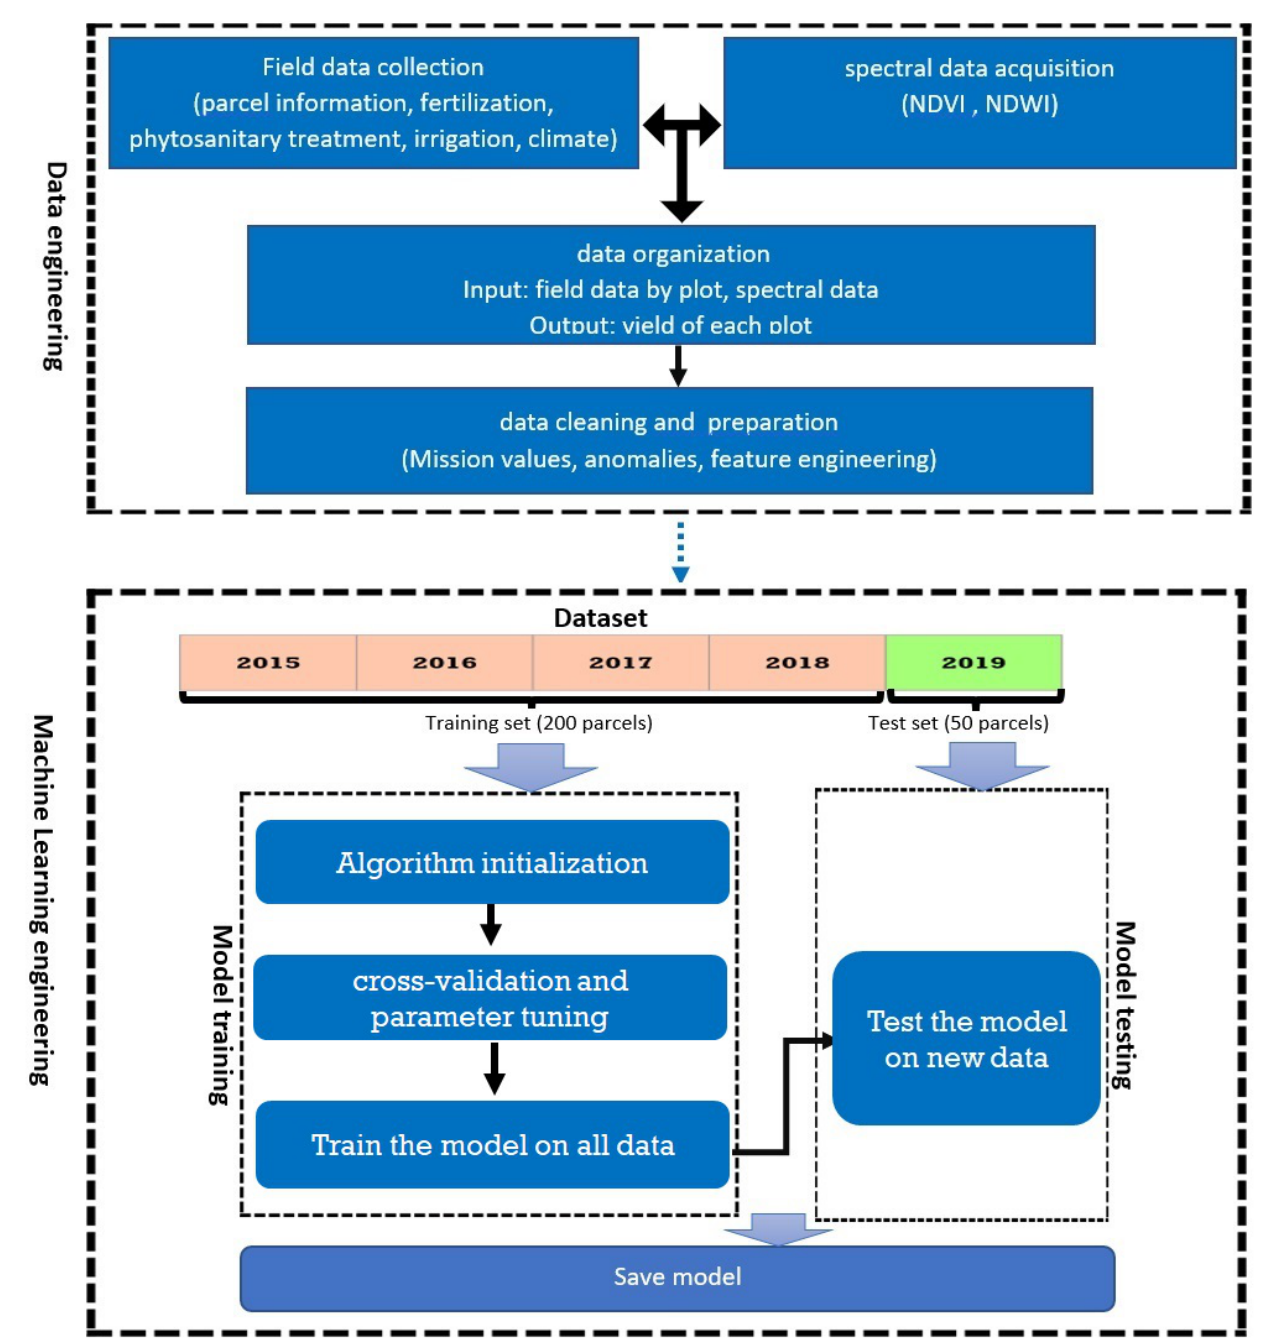
Figure 7. The overall approach: the approach includes data engineering and machine learning